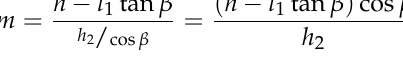
Figure 3. Side view of medicine storage tank.